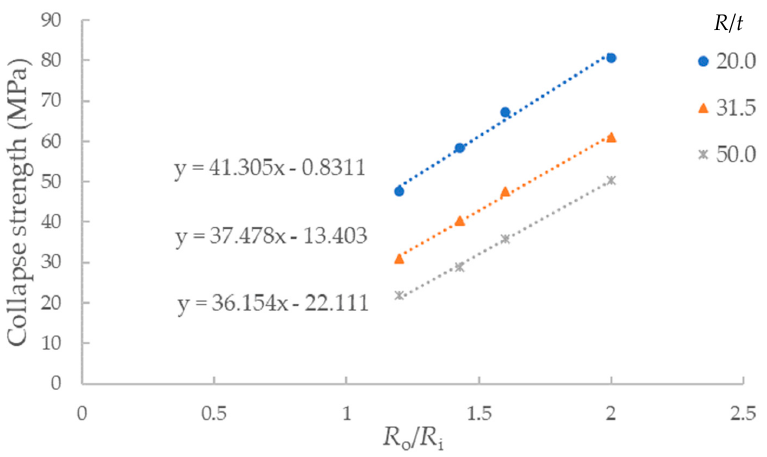
Figure 9. The relationship between collapse strength and parameter R o /R i ( λ / R o = 2.0, Δ = 0.2%).